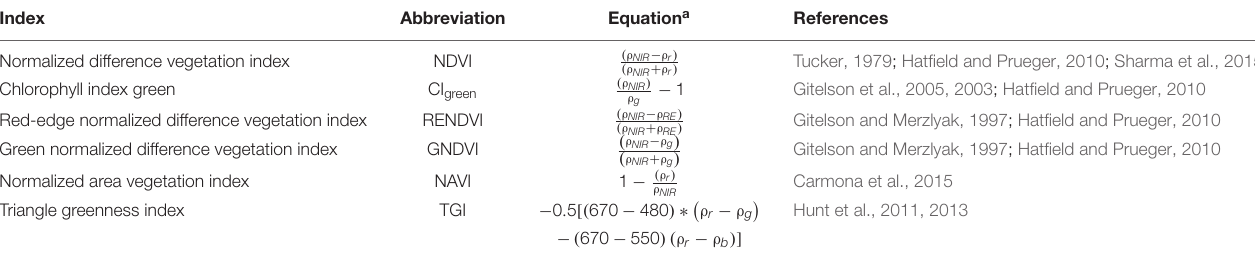
TABLE 1 | Vegetation indices.